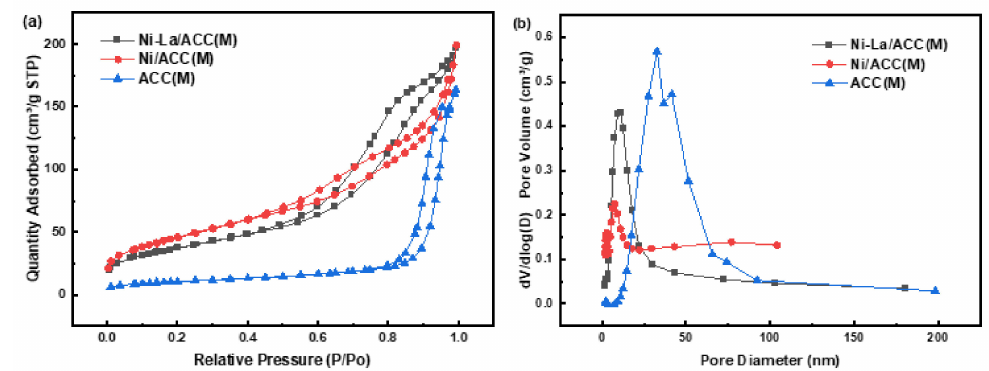
Figure 3. Adsorption isotherm and particle size distribution of catalysts: ( a ) Adsorption isotherm; ( b ) Particle size